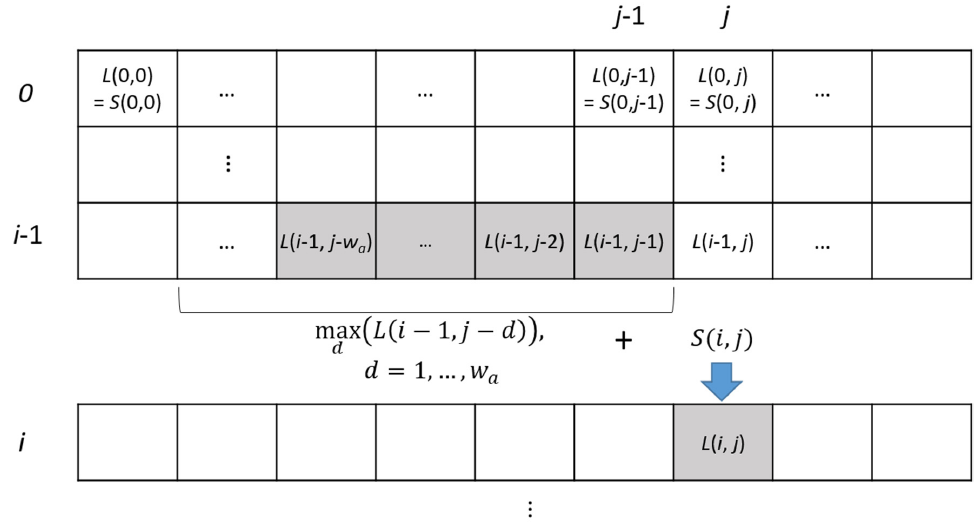
Figure 4. Aggregation of BoW-based similarity score for sequence matching.